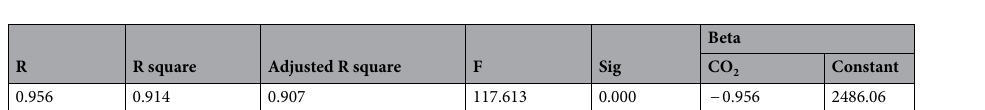
Figure 11. Results of CCA analysis between CO 2 and evapotranspiration for the first three modes carrying 91% of the correlation. For each mode, time series and maps of canonical modes are shown for both CO 2 concentration (left) and evapotranspiration (right).